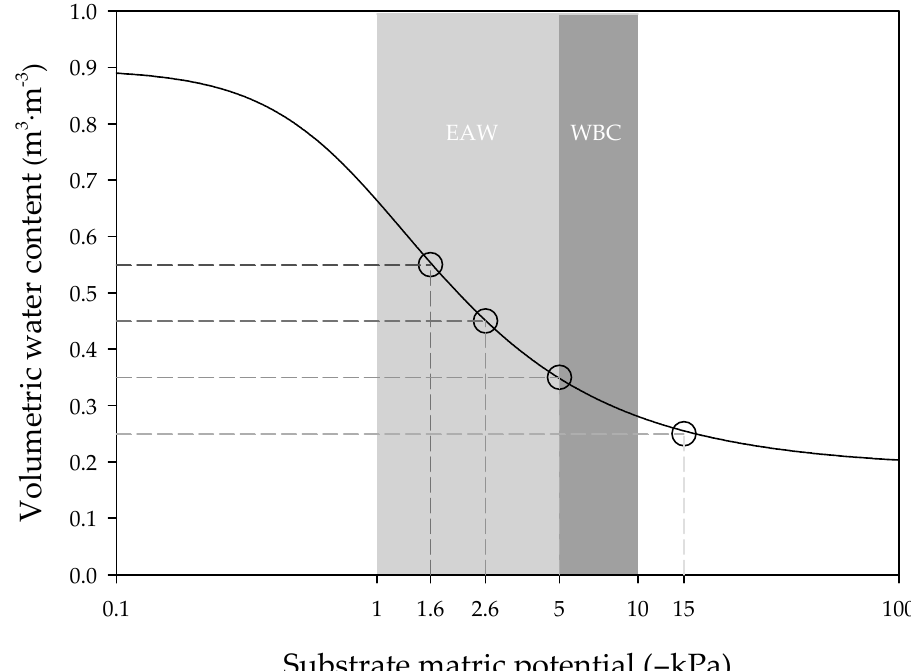
Figure 1. Moisture retention curve of the coir dust substrate used in this study using Hyprop (Meter Group, Pullman, WA, USA). The irrigation θ thresholds were set at − 1.6, − 2.6, − 5.0, and − 15.0 kPa, representing water contents of 0.55, 0.45, 0.35, and 0.25 m 3 ·m − 3 , respectively, within range of easily available water (EAW) and water buffering capacity (WBC). Each point indicates the relationship between setpoints and substrate matric potential.